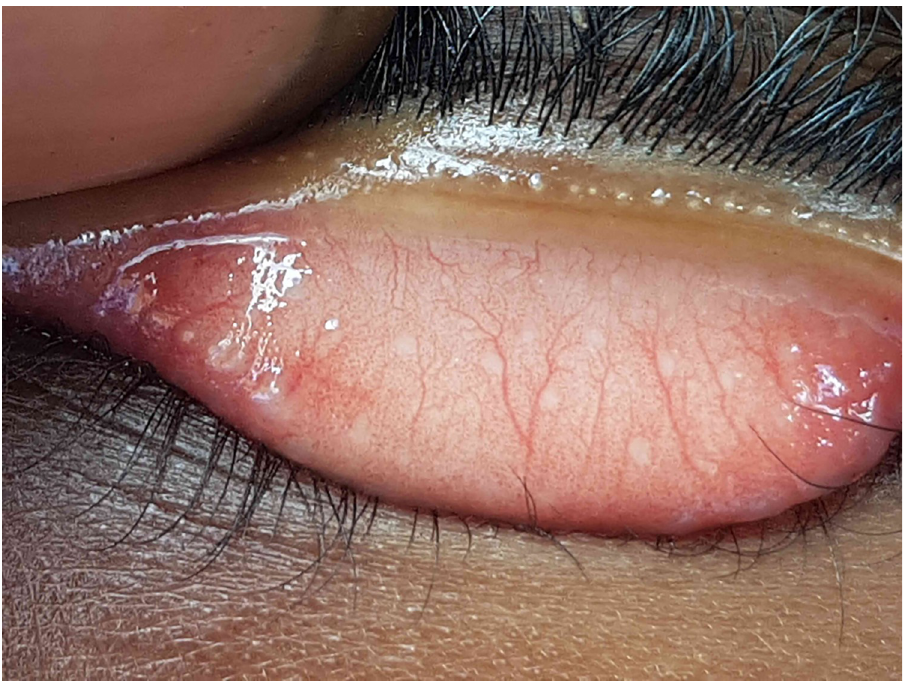
Fig 3. Example of a lid image taken by ICAPS.